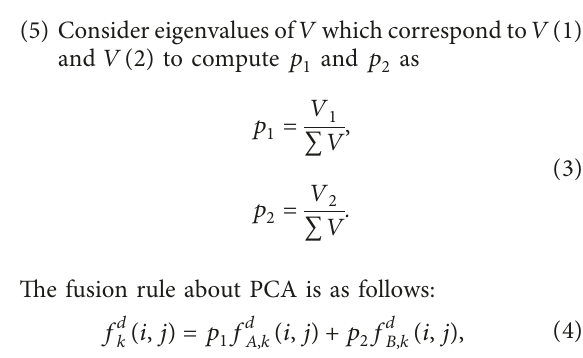
Figure 10: The two gray-scale images of the same defect. (a) One broken wire. (b) Two broken wires. (c) Three broken wires. (d) Four broken wires. (e) Five broken wires. (f) Seven broken wires.